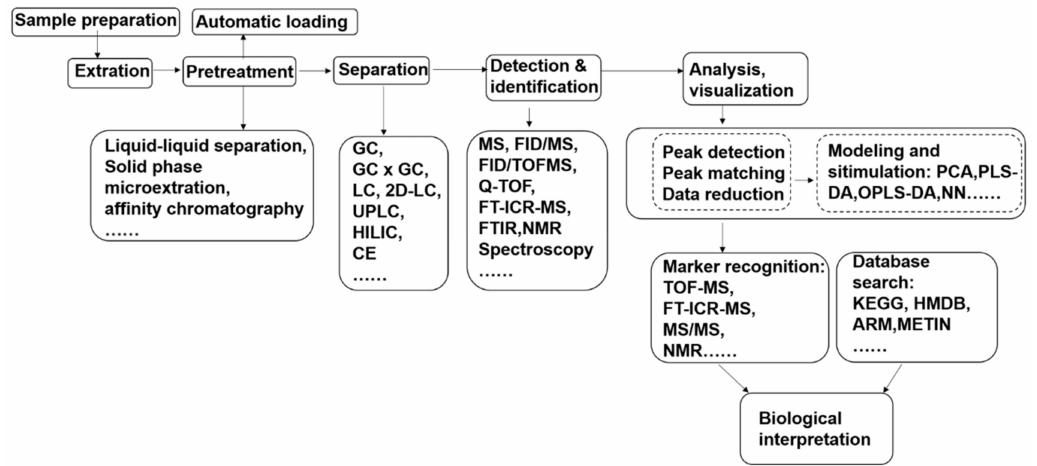
Figure 1. Metabolomics analysis flow for fungal pathogen–plant interaction research. PCA, principal component analysis; HCA, hierarchical cluster analysis; PLS-DA, partial least squares discriminant analysis; OPLS-DA, orthogonal partial least squares discriminant analysis; MUDA, multiple univariate data analysis; LDA, linear discriminant analysis; NN, neural networks; HMDB: human metabolome database; KEGG, Kyoto encyclopedia of genes and